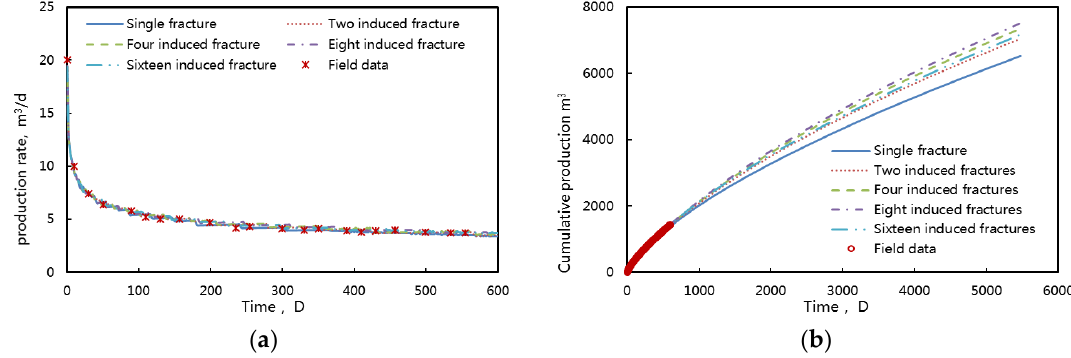
Figure 7. Fractal fracture network history matching combined with Changqing oil field data. ( a ) represent production rate with respect to different induced fracture scenario; ( b ) represent the cumulative production for all cases.